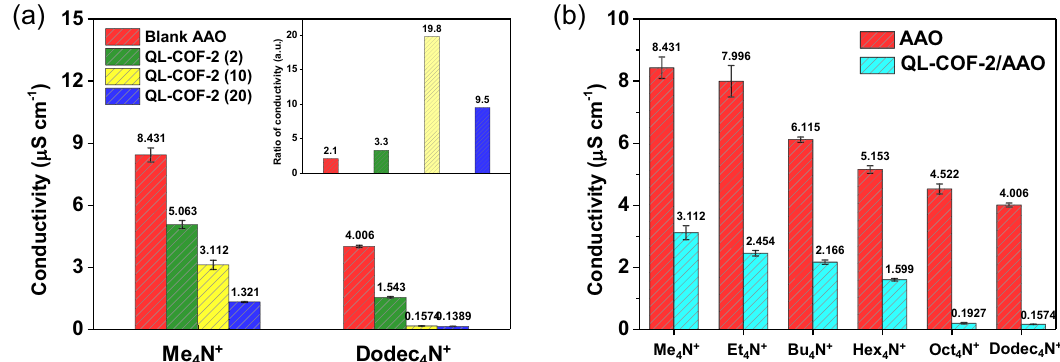
Fig. 5 Cation sieving experiments. a Transmembrane conductivity of Me 4 N + and Dodec 4 N + performed by blank AAO membrane and QL-COF-2/AAO membrane with different mass of COF. Inset: the conductivity ratio of Me 4 N + to Dodec 4 N + across different membranes. b Transmembrane conductivity of six cations across blank AAO and QL-COF-2 (10) membranes. Error bars donate standard